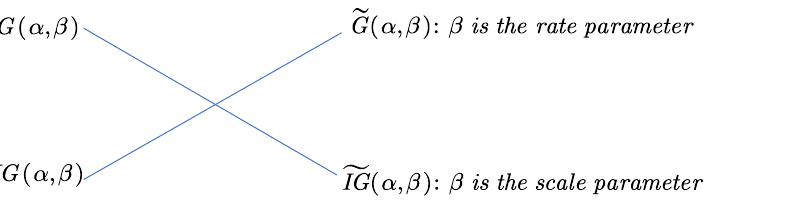
Figure 1. The gamma and inverse gamma distributions with a scale or rate parameter β